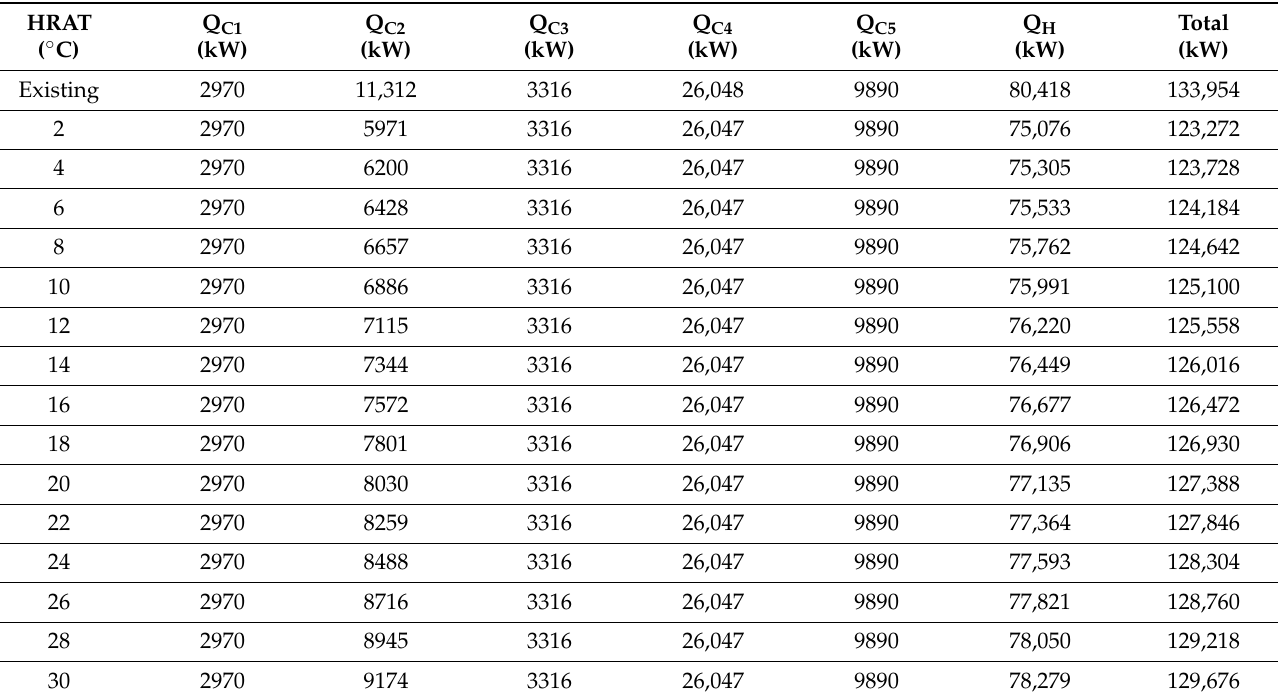
Table A6. External energy consumption at different HRAT values for option (1).